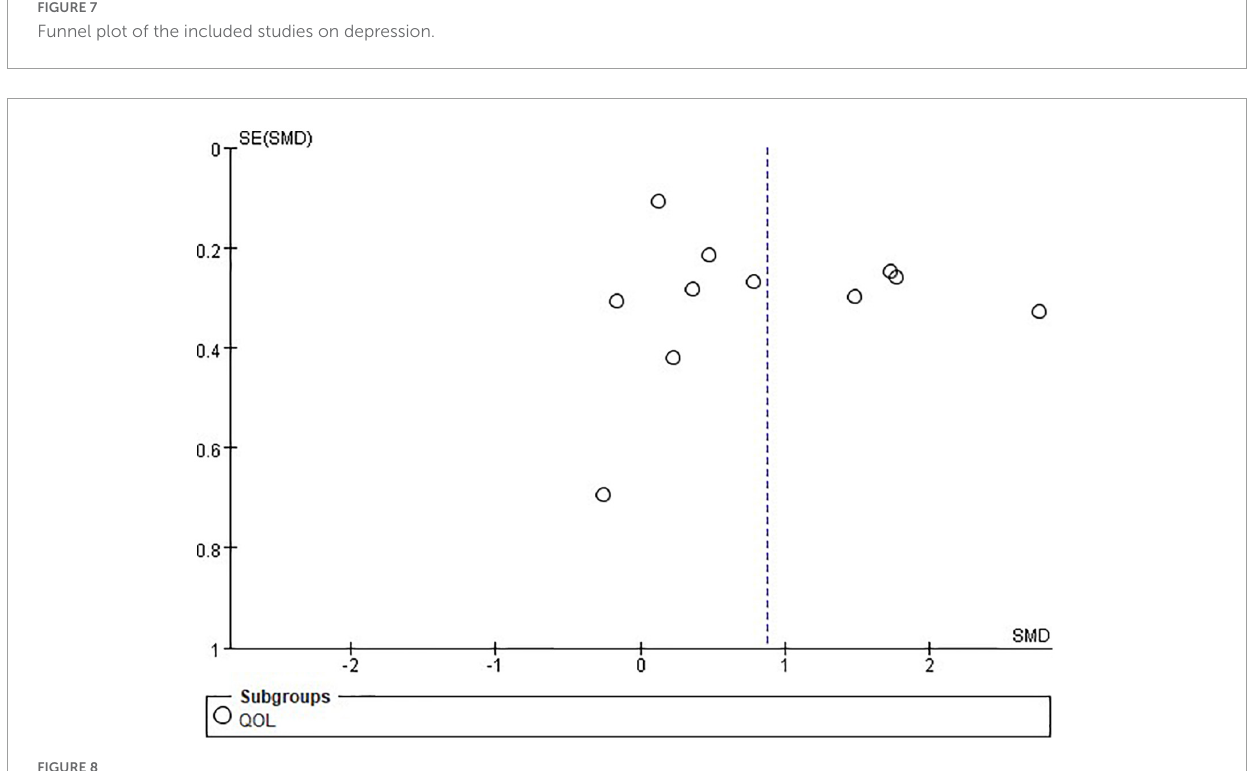
FIGURE8 Funnel plot of the included studies on quality-of-life (QOL).